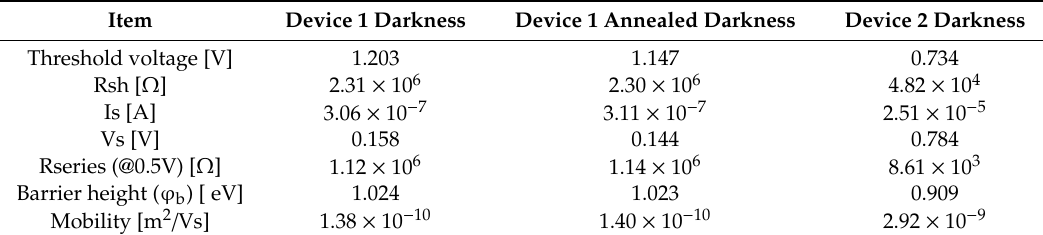
Table 2. Electronic parameters in